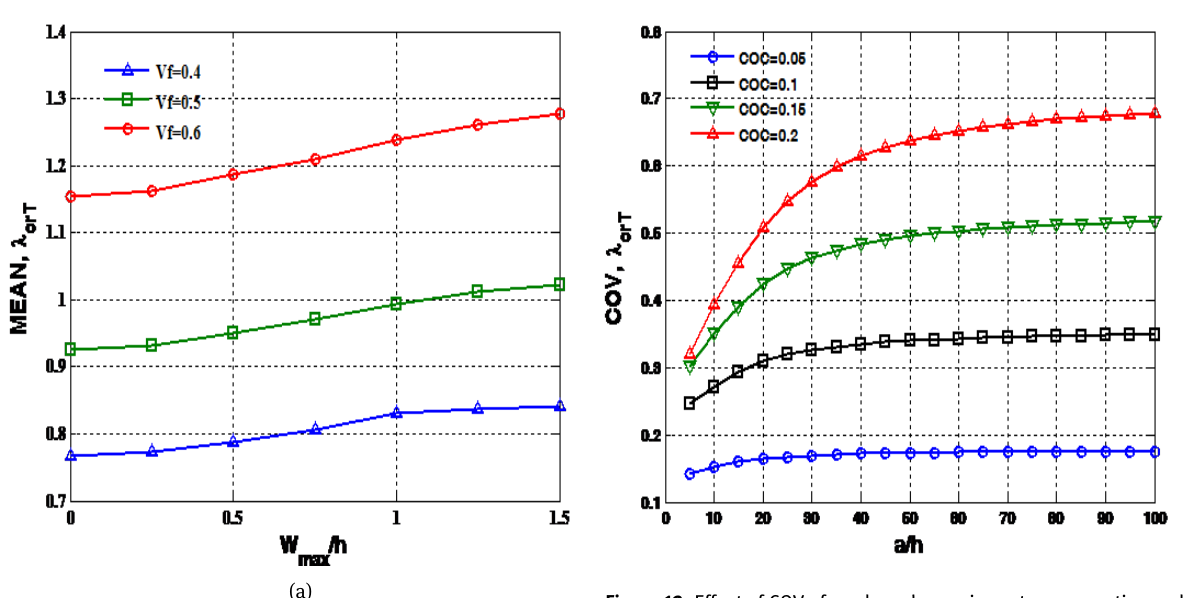
as compare to biaxial compression.